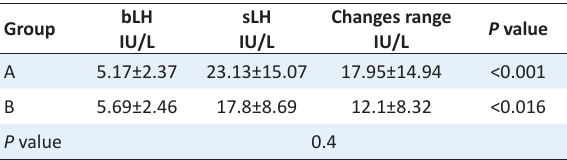
Table 2. The amounts (mean ± SD) of LH before and after stimulation test and changes range in groups A and B bLH sLH Changes range Group IU/L IU/L